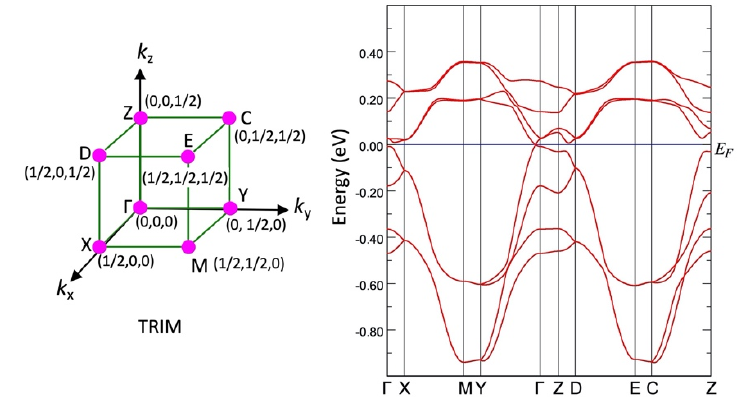
Figure 5. Electronic band structure of [Pd(dddt) 2 ] at 5.9 GPa connecting TRIMs.